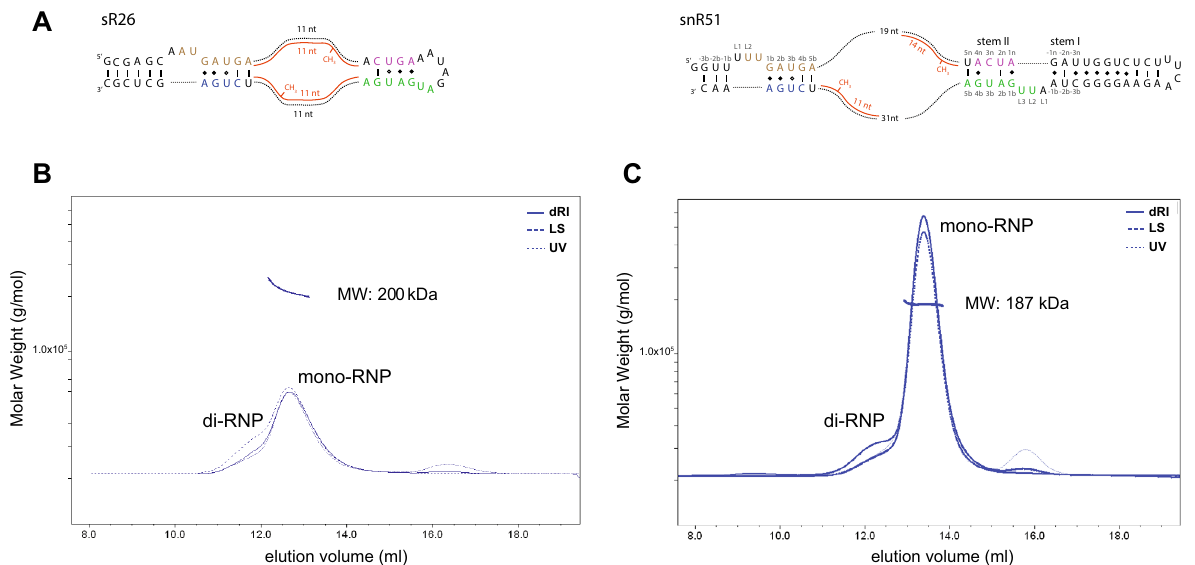
Figure 4. Snu13 does not bind to the putative box C’/D’ motifs of eukaryotic snoRNAs even when they are assembled in Box C/D complexes. ( A ) Sequence and predicted secondary structure of archaeal box C/D guide RNA sR26 and eukaryotic box C/D guide RNA snR51. Box C, box D, box C’ and box D’ are colored in brown, blue, green and purple, respectively. The guide sequences are shown base-paired with the rRNA substrates (red); the length of each complementary guide sequence is given below the substrate RNAs. ( B ) Multi-angle light scattering profile of the RNP containing snR51, Snu13, Nop5 and fibrillarin. ( C ) Multi-angle light scattering profile of the RNP containing sR26, Snu13, Nop5 and fibrillarin. The figure was prepared with Adobe Illustrator (Adobe Inc., 2020/21; https:// adobe. com/ produ cts/ illus